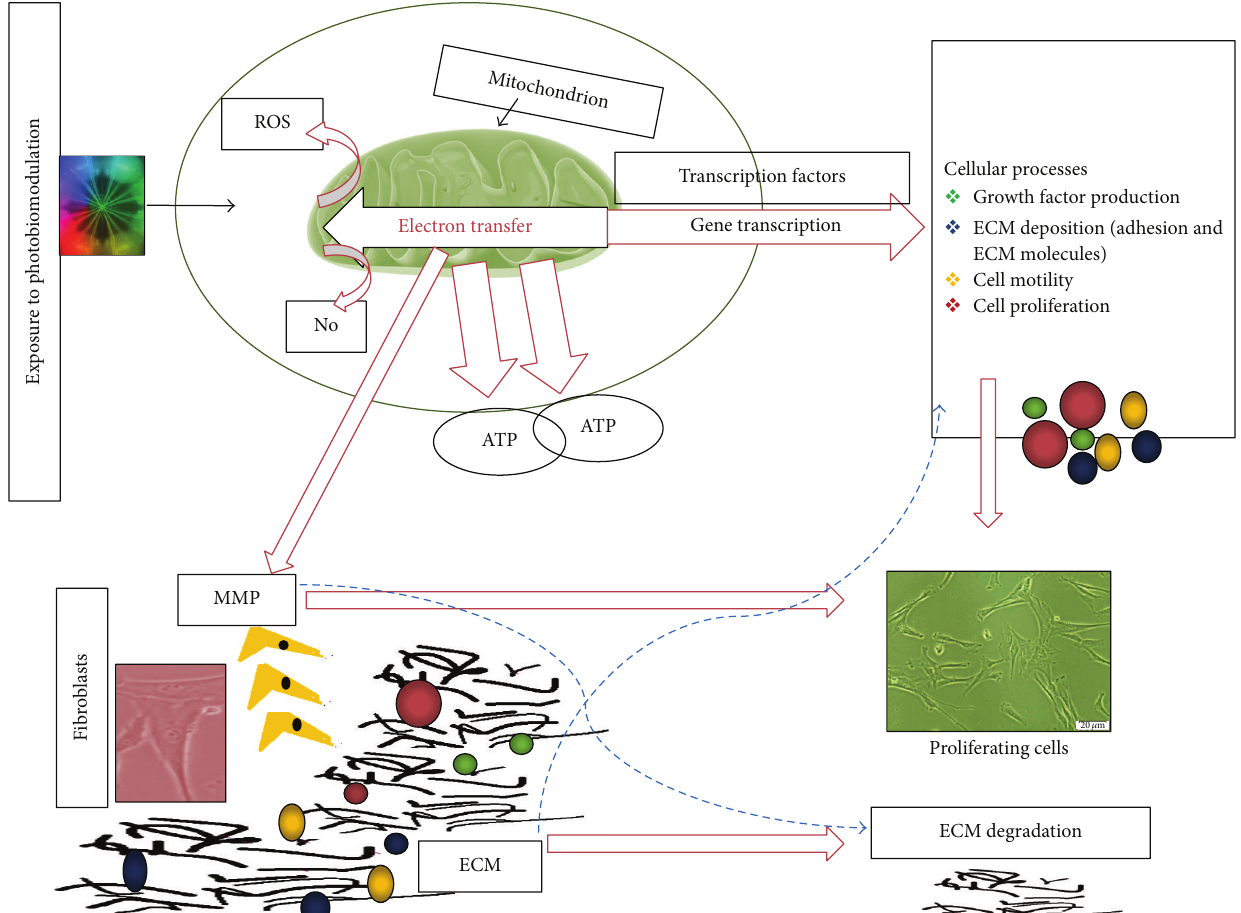
Figure 2: The interaction of photobiomodulation (PBM) and the extracellular matrix (ECM). Light absorbed by photons in the electron transport chain within the mitochondria generates the production of Adenosine Triphosphate (ATP), Reactive Oxygen Species (ROS), and Nitric Oxide (NO). This evokes the release of transcription factors leading to the transcription of genes, which develop and enhance various cellular processes. Matrix Metalloproteinases (MMPs) are associated with changes that occur in the ECM. Under disease conditions, excess MMP is expressed which leads to the enhanced degradation of the ECM. When cells are exposed to PBM, there is an enhancement in the release of various cells including fibroblasts, growth factors, and adhesion molecules into the basement membrane leading to ECM